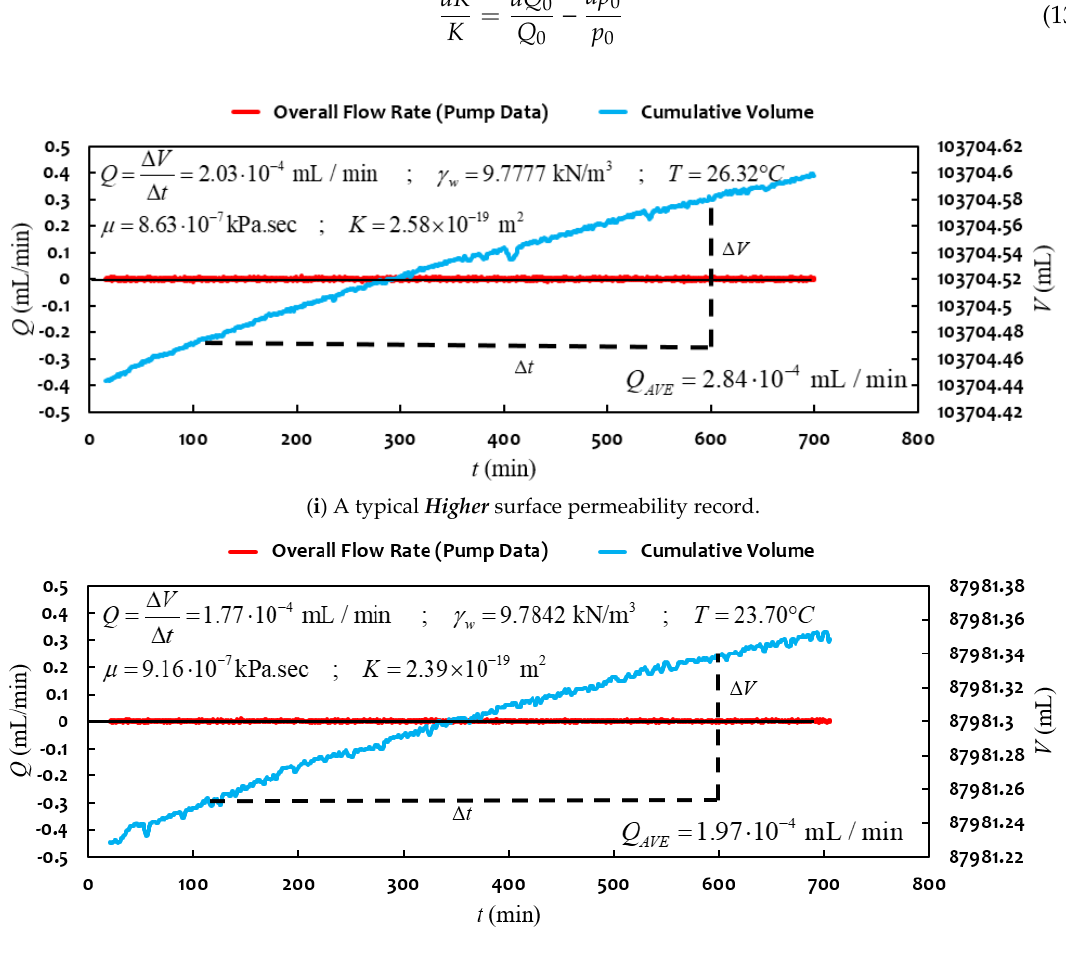
Figure 9. A typical flow rate and cumulative flow records from surface permeability tests conducted on the Lac du Bonnet granite cuboid.